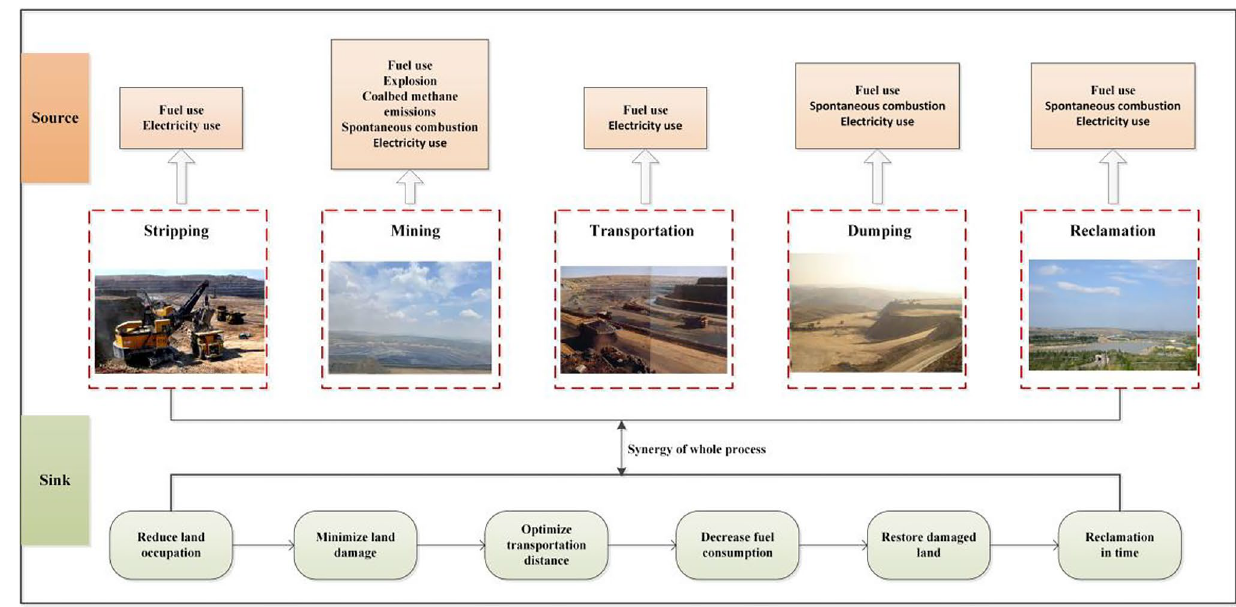
Fig. 5 Path to carbon neutrality in the mining